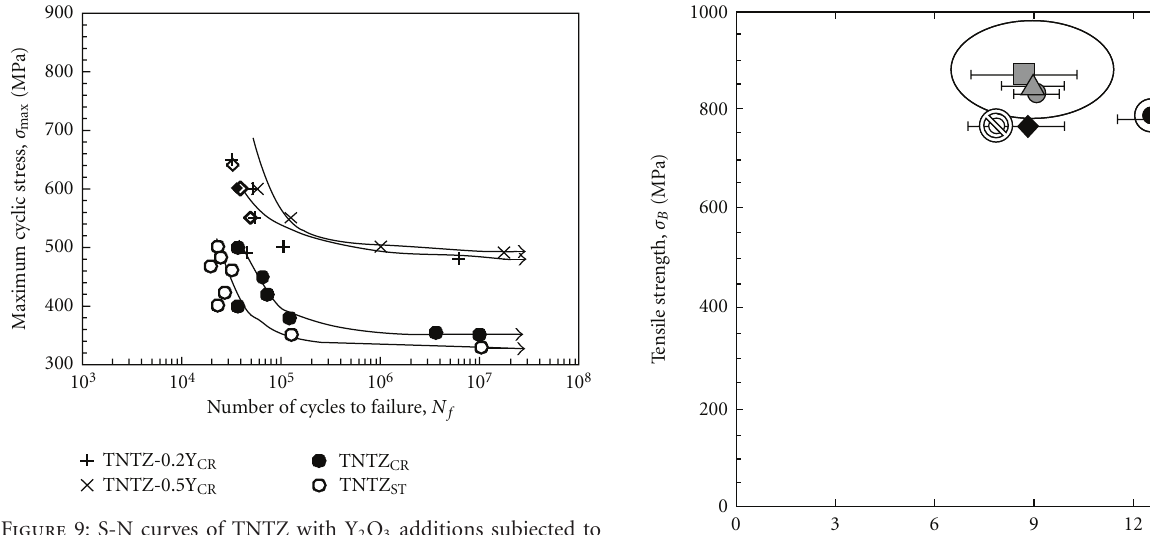
Figure 9: S-N curves of TNTZ with Y 2 O 3 additions subjected to cold rolling after solution treatment along with those of TNTZ subjected to solution treatment or cold rolling after solution treatment.